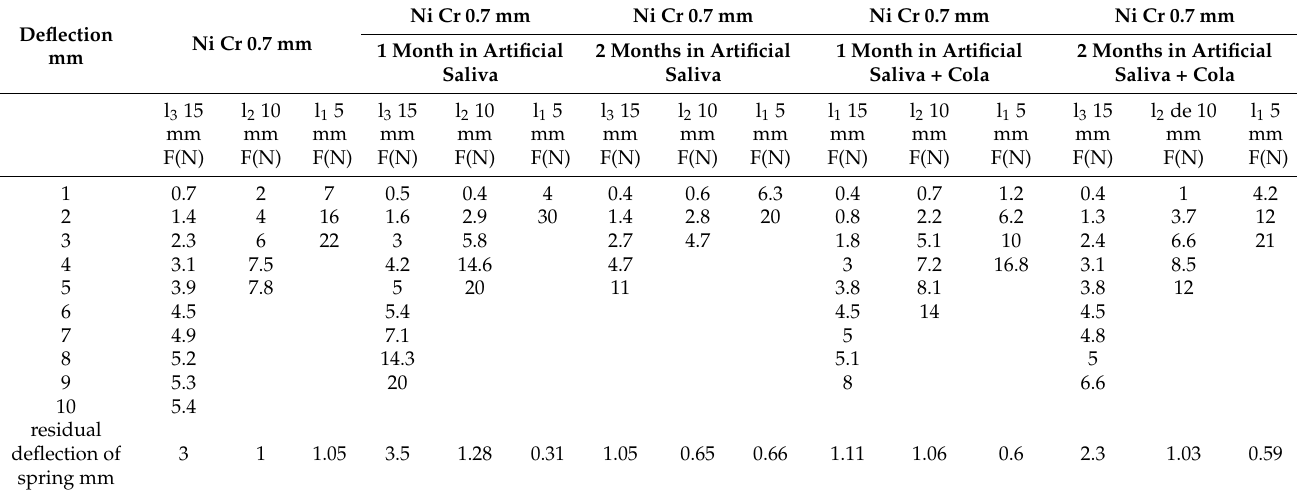
Table 1. Results for Ni-Cr 0,7 mm